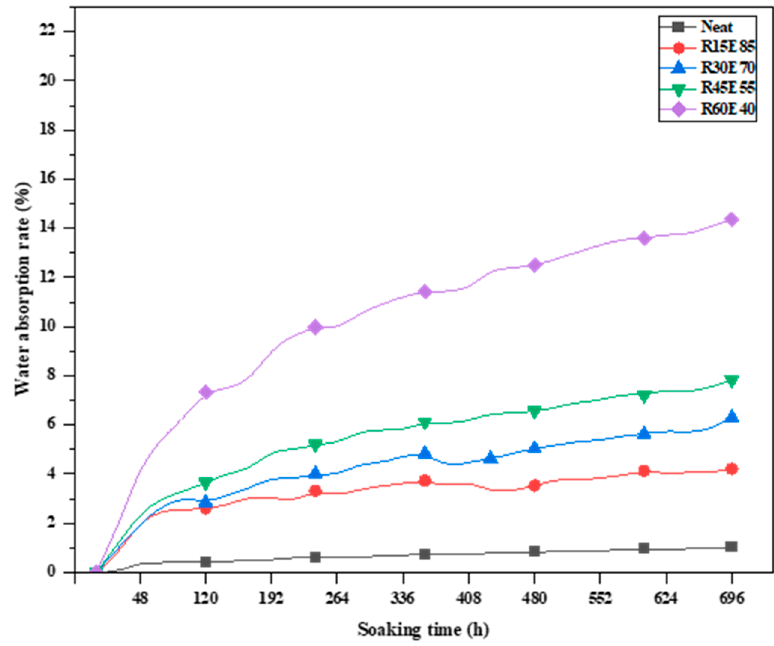
Figure 15. Water absorption rate of the RS p test samples.